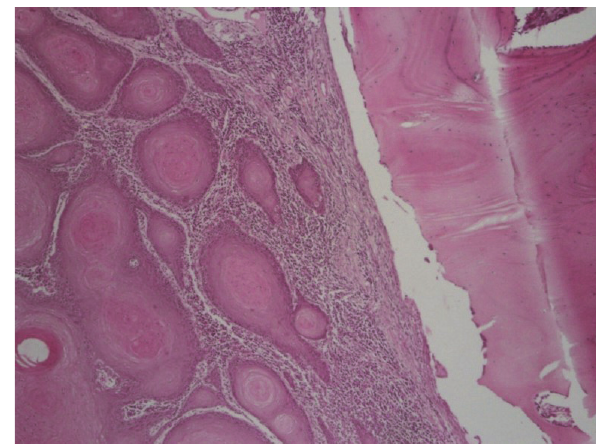
Fig. 2. Infiltrative form of bone invasion by oral squamous cell carcinoma (Hematoxylin and Eosin staining, 40x).